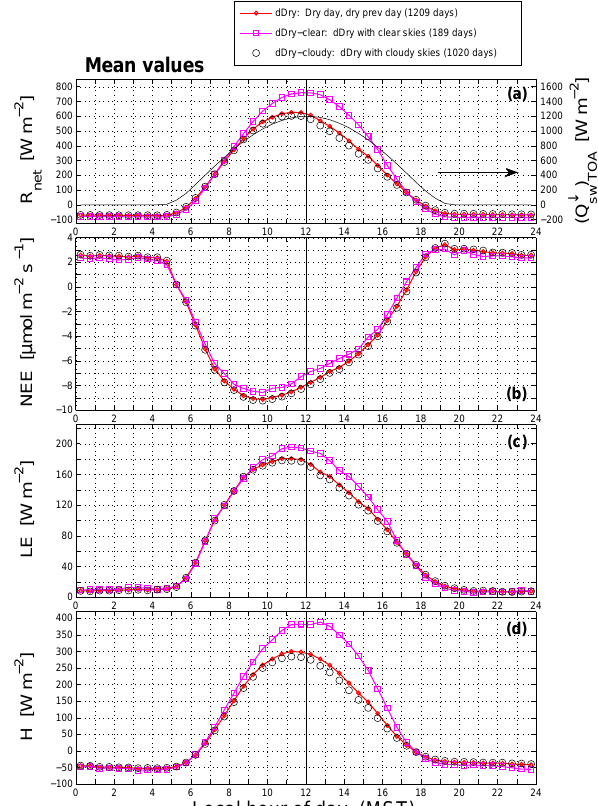
Figure 12. The mean warm-season diel cycle of (a) net radiation R net (left-hand axis) and top-of-the-atmosphere incoming short- ↓ wave radiation ( Q ) TOA (right-hand axis, thin black line), (b) net SW ecosystem exchange of CO 2 NEE, (c) latent heat flux LE, and (d) sensible heat flux H , for dDry conditions. This is the same as the dDry column in Fig. 9, except the data have been further sepa- rated into dDry-Clear and dDry-Cloudy conditions as specified by the legend. For further details see the caption of Fig.